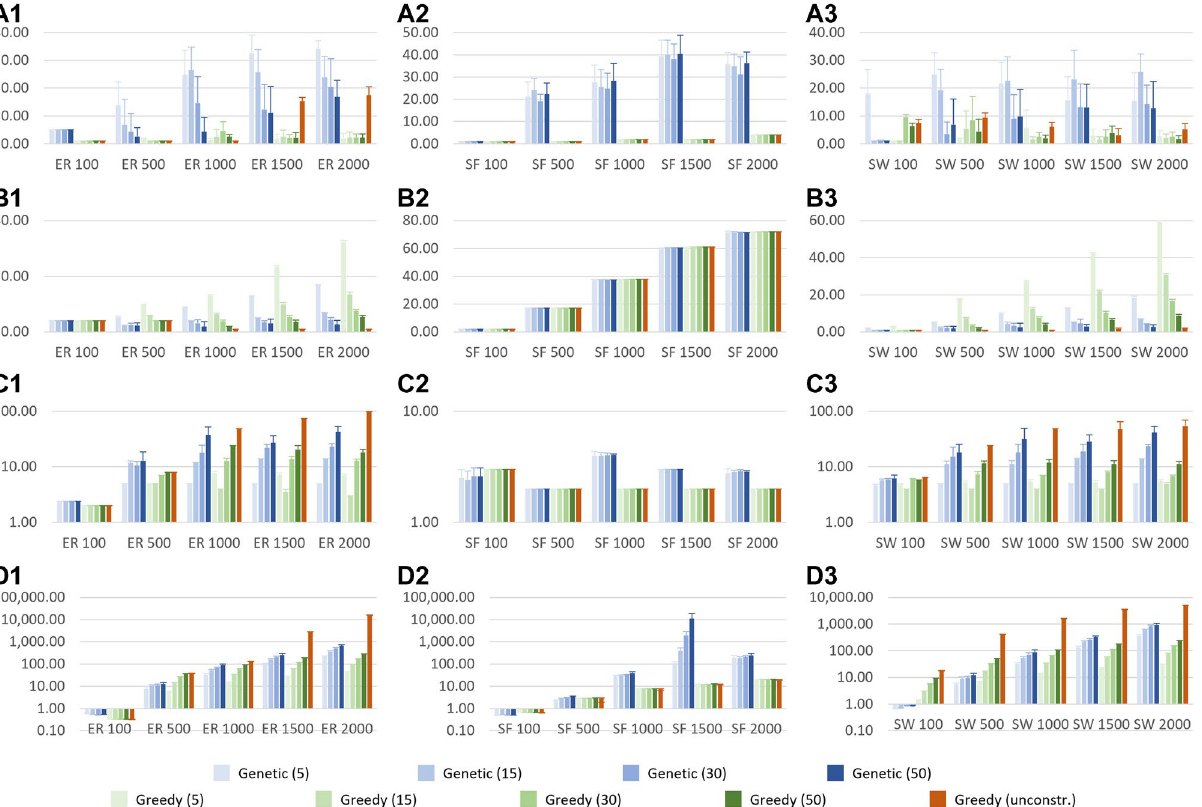
Figure 2. The results of the algorithms on the random networks. For all colors, the darker the shades, the longer are the maximum allowed control paths. ( A ) The number of the identified solutions, ( B ) the size of the solutions, ( C ) the length of the control paths in the solutions, ( D ) running time. Column 1: the Erdős–Rényi networks, column 2: the Scale-Free networks, column 3: the Small World networks. In blue: the results of the genetic algorithm, in green: the results of the constrained greedy algorithm, in orange: the results of the unconstrained greedy algorithm; from left to right, all plots: the networks with 100/500/1000/1500/2000